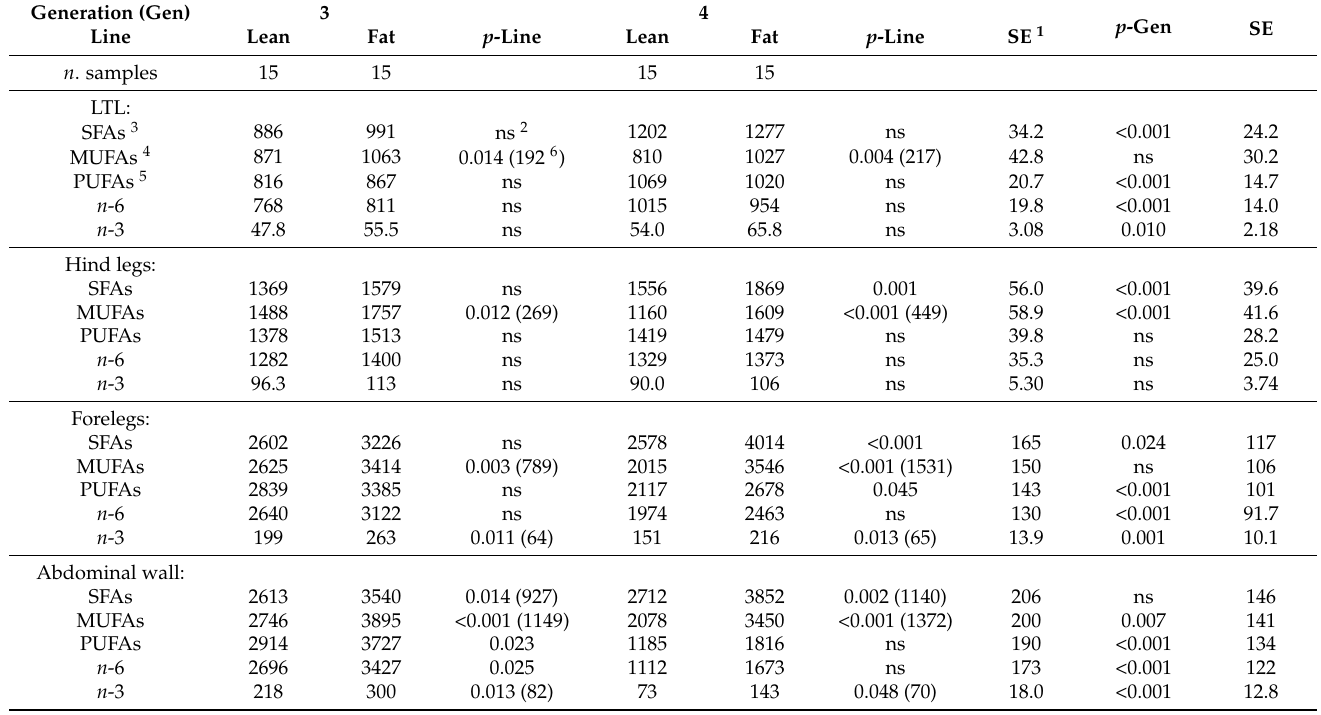
Table 6. Content (mg/100 g of meat) of main FA classes of the four meat portions ( longissimus thoracis et lumborum (LTL), hind legs, forelegs, abdominal wall) of Lean and Fat rabbits in third and fourth generations of divergent selection for total body fat